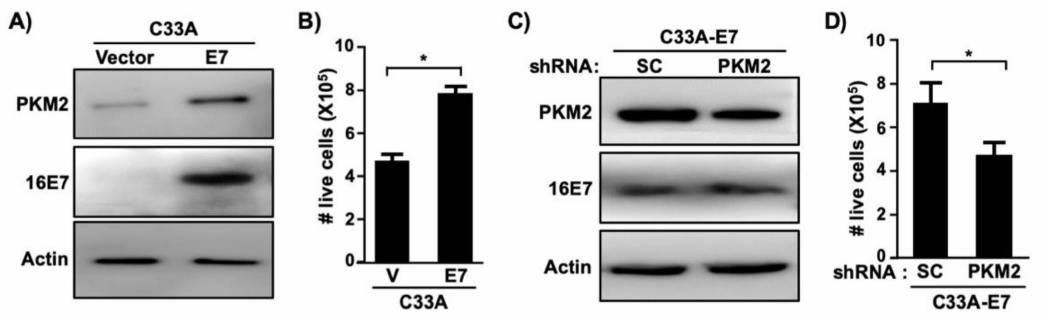
Figure 3. HPV16 E7-induced proliferation of cervical cancer cells depend on PKM2. ( A ) C33A cells stably expressing HPV16 E7 or empty vector were generated using retroviral vectors. Cell extracts were analyzed with western blot. ( B ) Cells described in A were seeded in 24-well plates (20,000 cells/well) and counted after 5 days. Results from five independent experiments are shown as mean ± S.E.M. V, vector. * p = 0.005 (two-sided Student’s t -test). ( C ) C33A-E7 cells were transduced with retrovirus expressing scrambled (SC) shRNA or PKM2 shRNA. Total cell extracts were subject to western blot. ( D ) Cells described in C were subject to cell counting assay, as described in B. Results from three independent experiments are shown as mean ± S.E.M. * p = 0.01 (two-sided Student’s t -test).